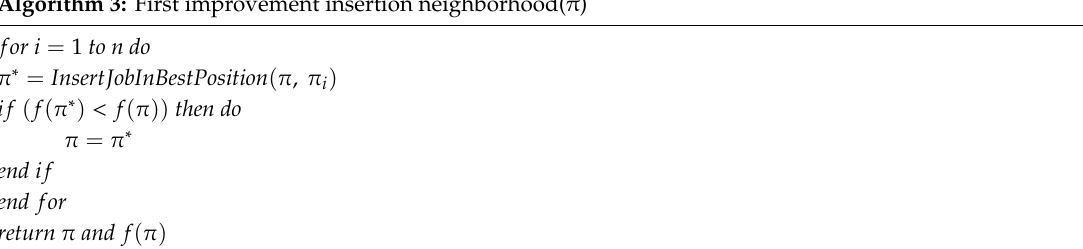
Algorithm 3: First improvement insertion neighborhood( π )